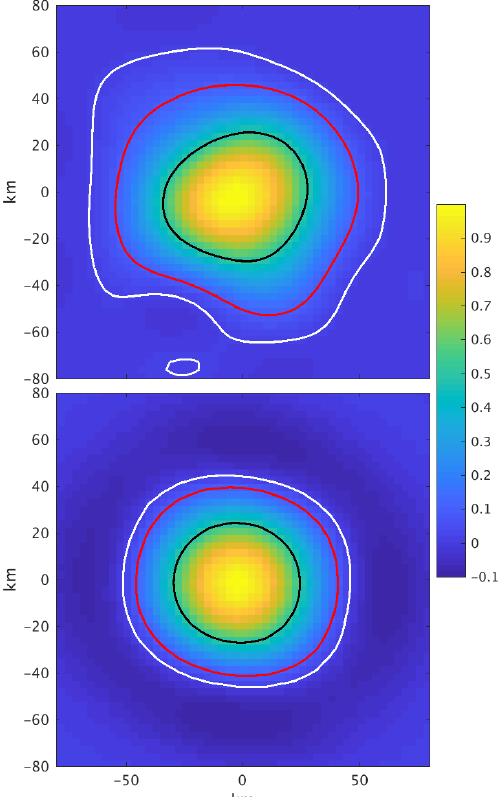
Figure 2. Comparison of ( top ) the drop-in-the-bucket (DIB) PRF and ( bottom ) the rSIR PRF. Black contours are at − 3 dB; the red contours are at − 6 dB; and the white contours are at − 10 dB from the normalized peak at the center. Note the tighter contours of rSIR compared to